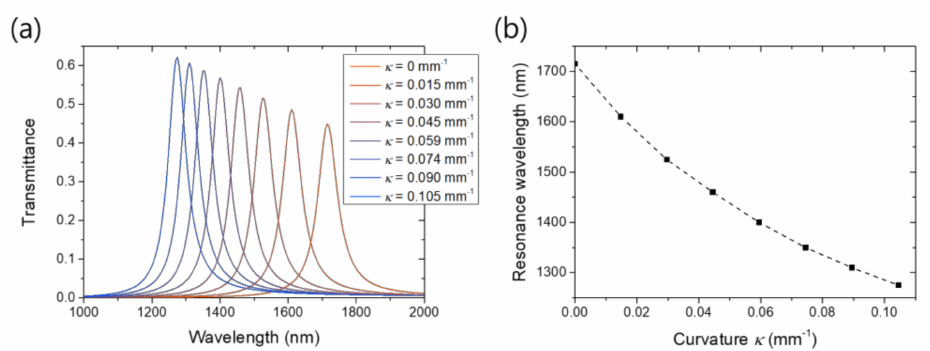
Figure 3. Blueshift of the Fabry–Perot resonance: ( a ) Transmission spectra for the various bending curvature; ( b ) Resonance wavelength as a function of the curvature.